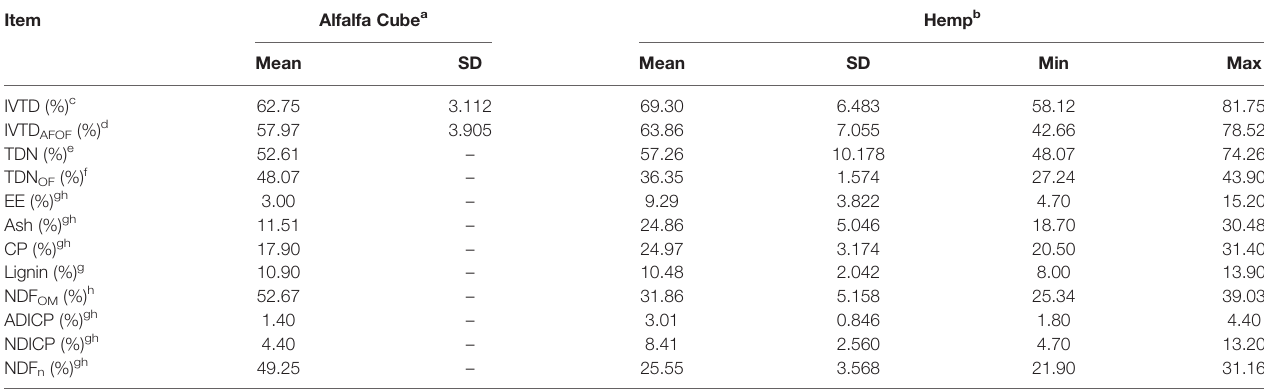
TABLE 4 | Descriptive statistics for digestibility and nutrient concentrations of in fl orescence from 9 CBD-extracted hemp cultivars.